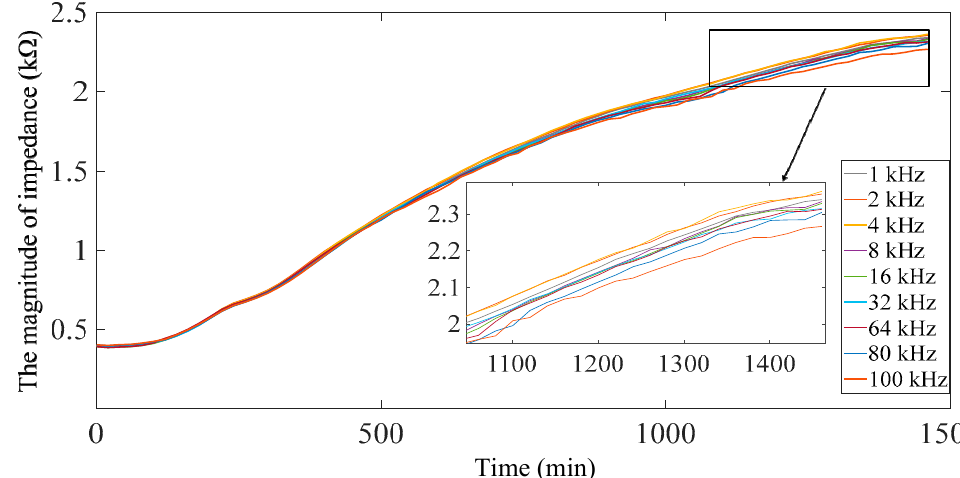
Figure 10. The magnitude curves of impedance by the nanocrystalline T37 current sensor.